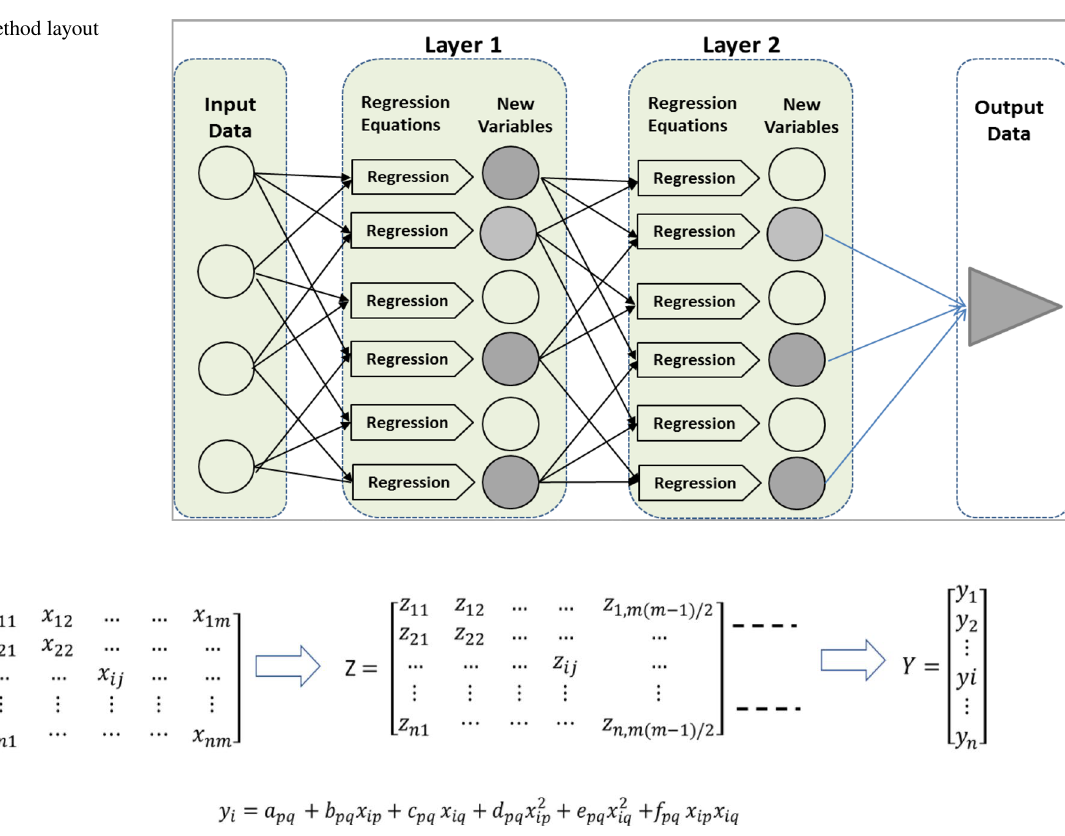
Fig. 11 GMDH method